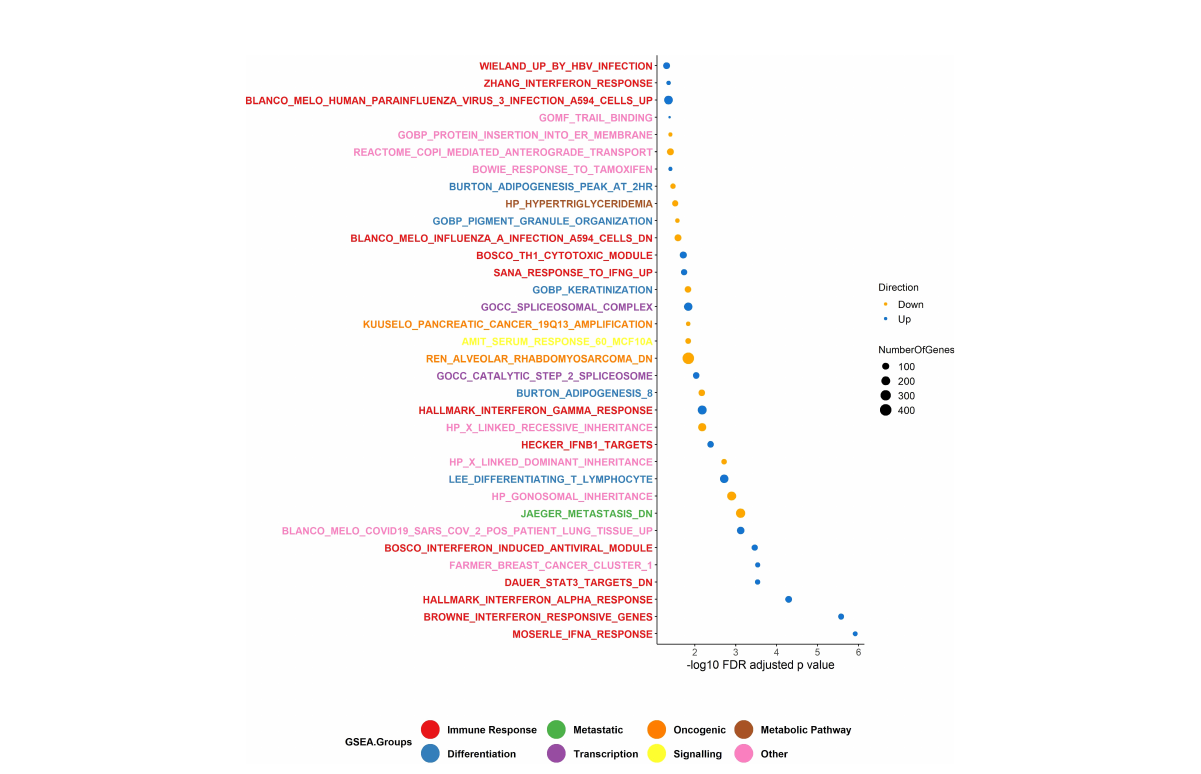
FIGURE 6 Gene set enrichment analysis (GSEA). The upregulated GSEA groups in the responder group of patients were enriched for genes involved in the immune response pathway and transcription, and the down-regulated genes were enriched for genes in differentiation, viral mimicry, and metabolic pathways. Number of responders = 10 and non-responders = 10. In total, 34 gene sets were identi fi ed in GSEA using CAMERA test. The p-value is